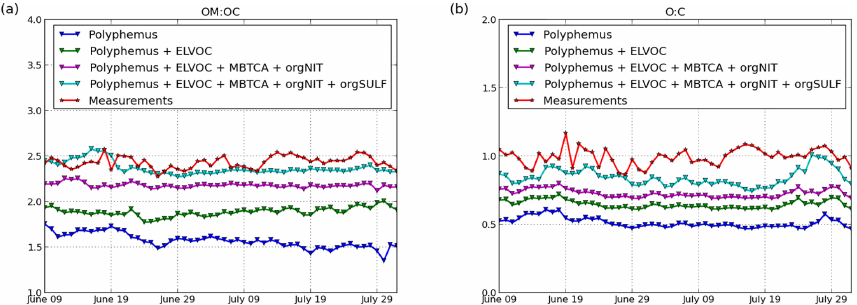
Figure 6. Daily variations of the ratios OM / OC ( a ) and O / C ( b ) during the 2013 campaign. The red line represents the measurements. The blue line represents model results without taking into account the concentrations of ELVOCs, MBTCA and organic nitrate. The green and magenta lines represent the model results by also taking into account ELVOCs (green) and MBTCA and organic nitrate (magenta). The cyan line represents the model results when assuming that a surrogate from isoprene oxidation is an organosulfate.